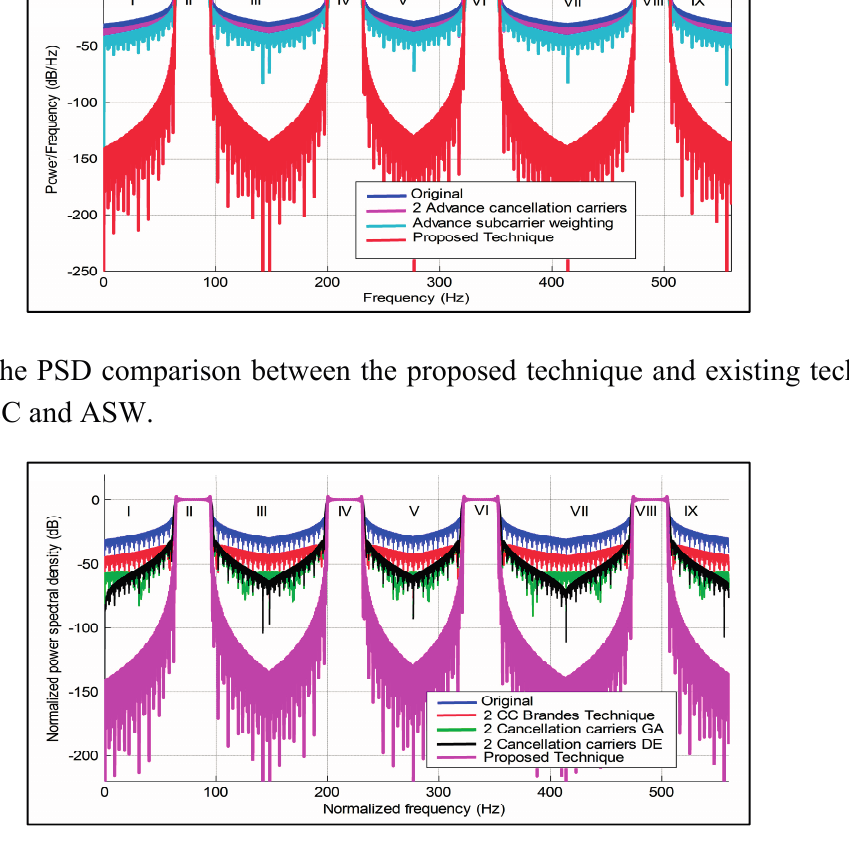
Figure 11. The PSD comparison between the proposed technique and existing techniques including CC (Brandes), CC (GA), and CC